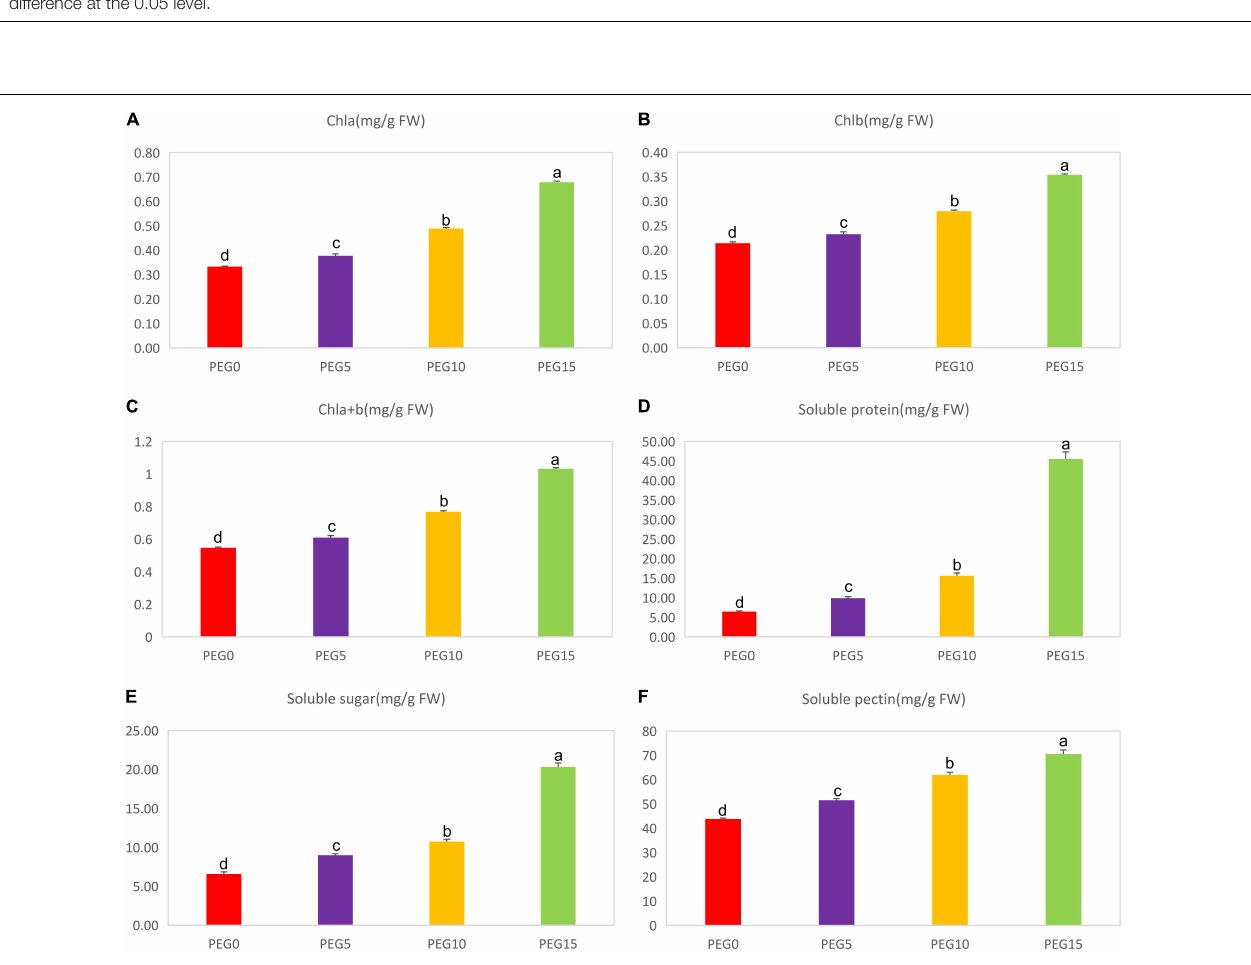
FIGURE 2 | Changes in the fresh weight of the whole plant, root, and above-ground under different drought stress conditions. Different letters indicate the significant difference at the 0.05 level.